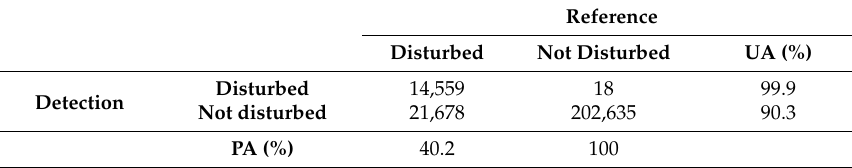
Table 3. Confusion matrix of UMD-GLAD Forest Alert